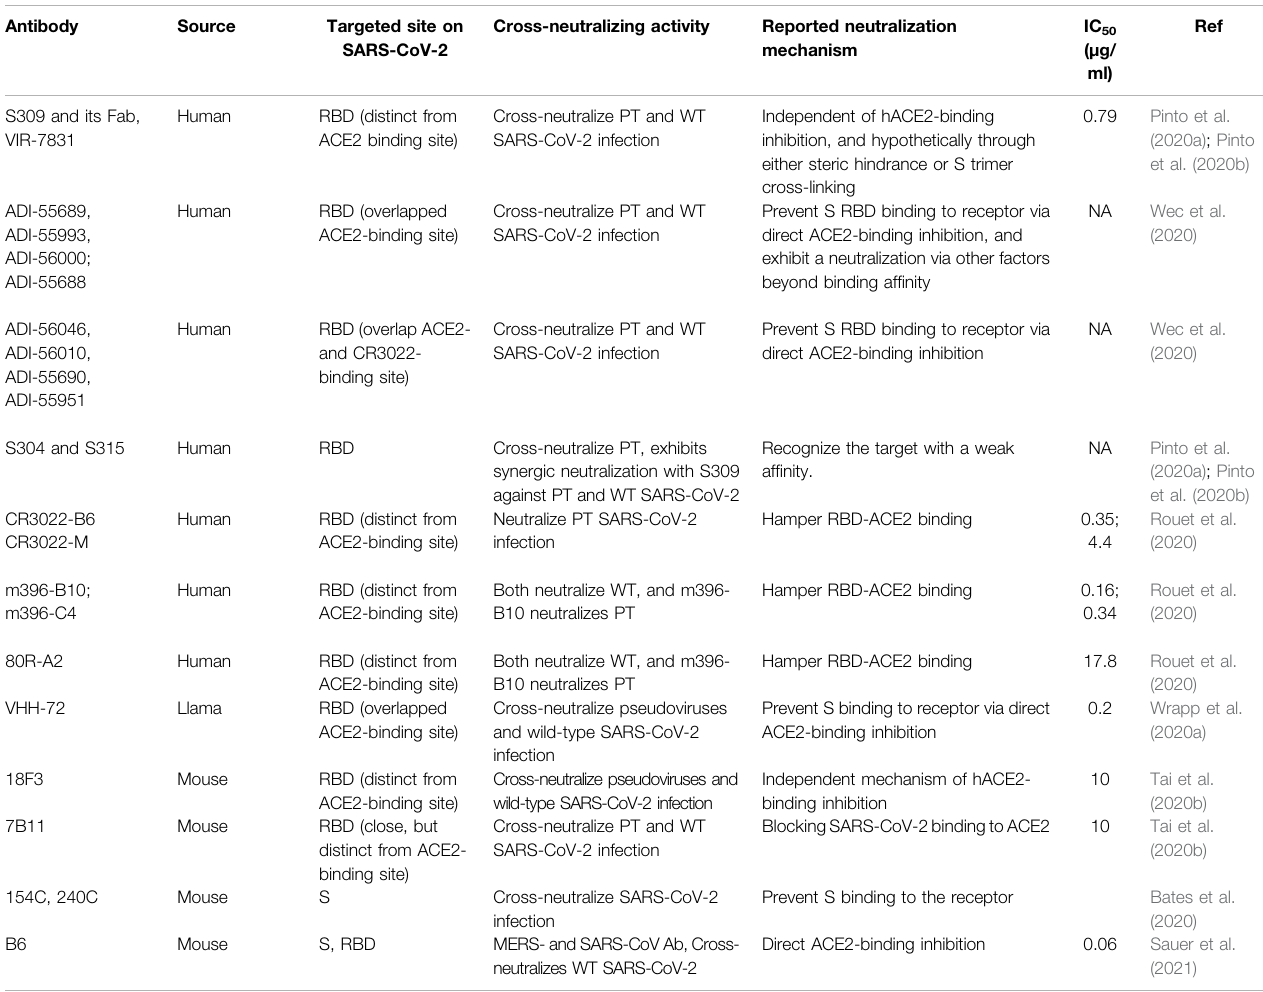
TABLE 1 | SARS- and MERS-CoV-speci fi c NmAbs with cross-neutralizing activity against SARS-CoV-2.